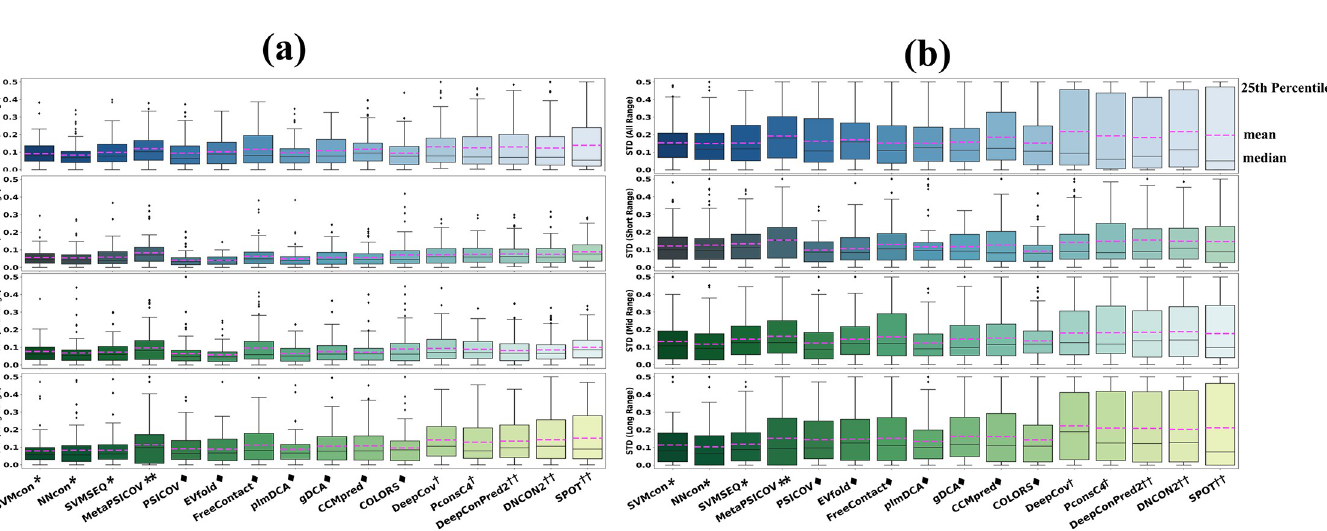
between intra-domains, particularly for all- and long-range contacts by DL methods. In top L/5 predictions, all DL methods show precision biases between intra-domains on at least 25% proteins with STD larger than 0.4. Take SPOT for example, there are 25% proteins with STD > 0.45 for all- and long-range contacts, which means for one (some) domain(s) in these proteins the prediction precision(s) is (are) perfectly close to 100%, while the predic- tion precisions of other domain(s) is (are) close to 0. The results deliver the facts that precision imbalances exist in (1) inter- vs . intra-domains predictions as well as (2) intra- vs . intra-domains in the same protein, and the phenomena are